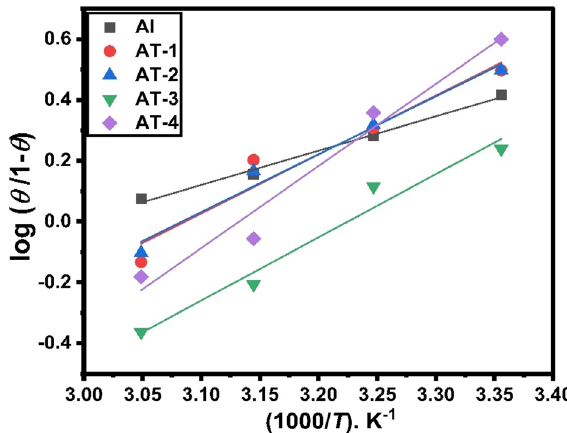
Figure 9. Plot of log (θ/1 − θ) against 1000/ T for aluminum and Al–Ti alloys in 0.5 M HCl containing 1 mM of 2-MBT inhibitor.